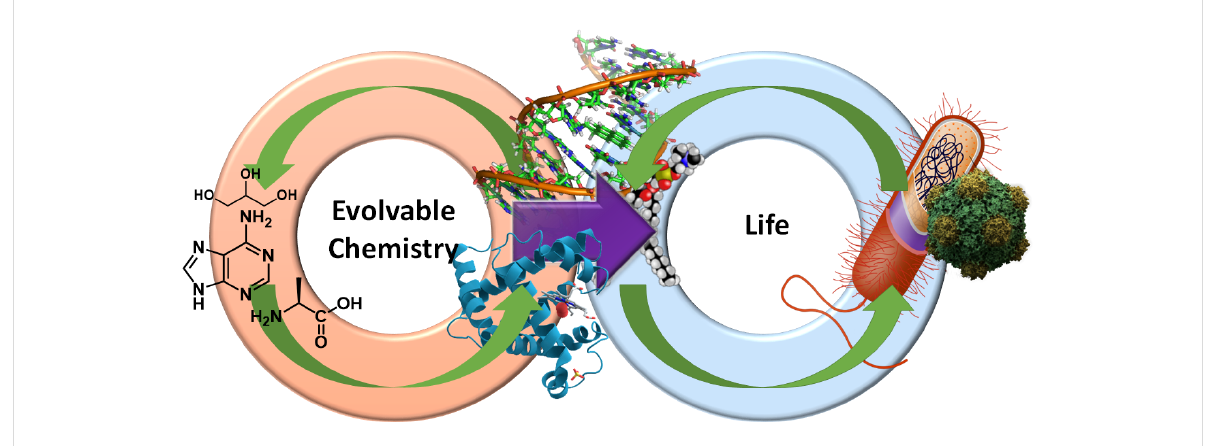
Figure 1: Evolution of life from non-living, complex chemistry via chemical evolution of complex chemical composites towards increasing complexity. A transition to biological evolution occurs when composites become sufficiently complex to transition from chemical to biological units. Green arrows indicate continuous adaptation and complexification under selection pressure; the purple arrow indicates the transition from evolving chemical com- posites to evolving living units after exceeding a complexity threshold.